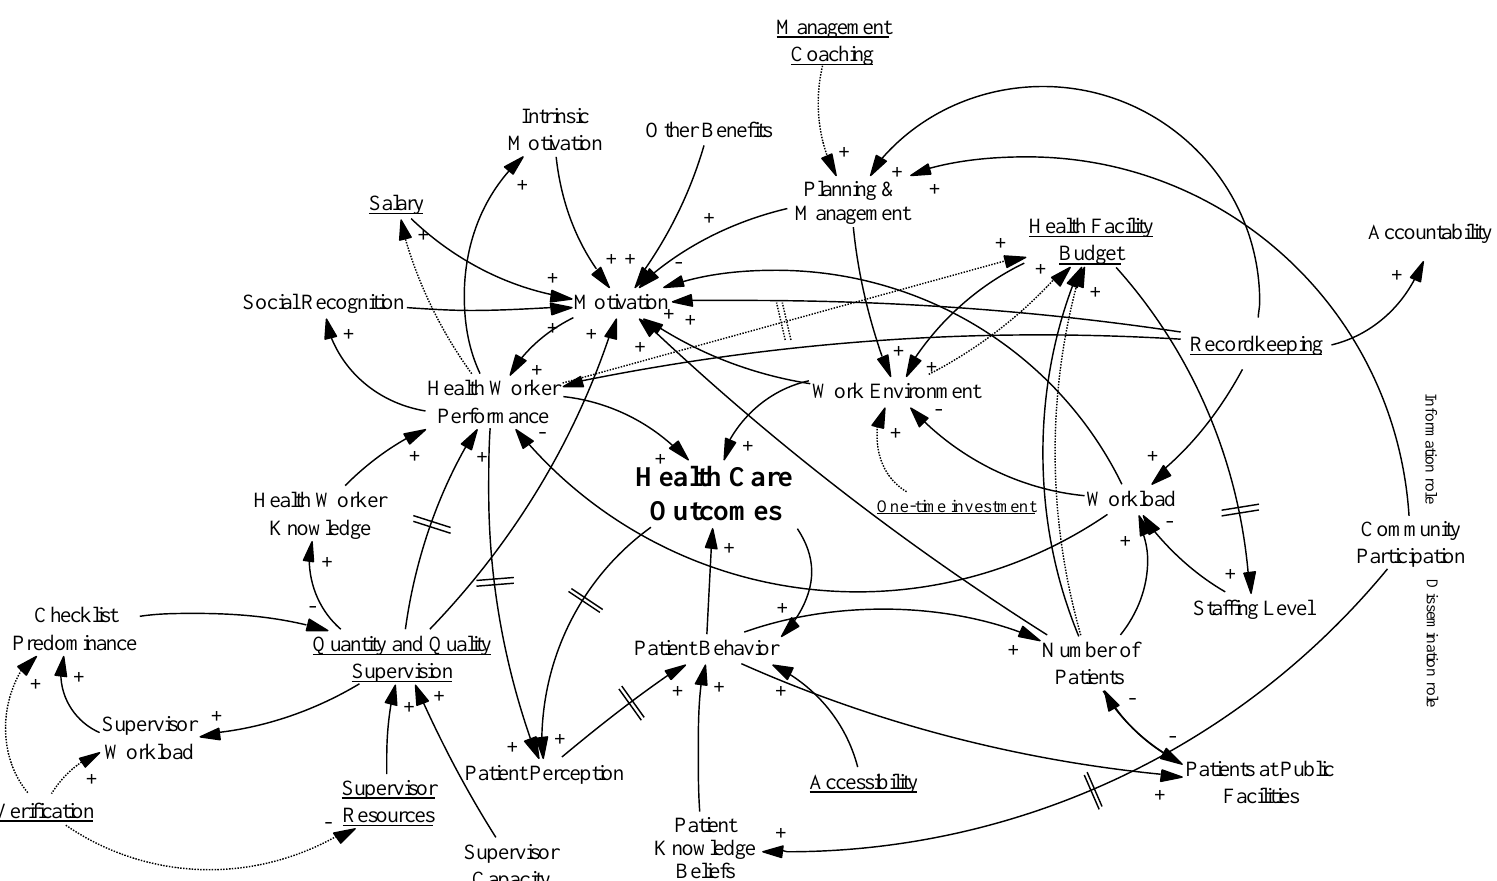
Figure 4. Causal loop diagram with the introduction of PBF.